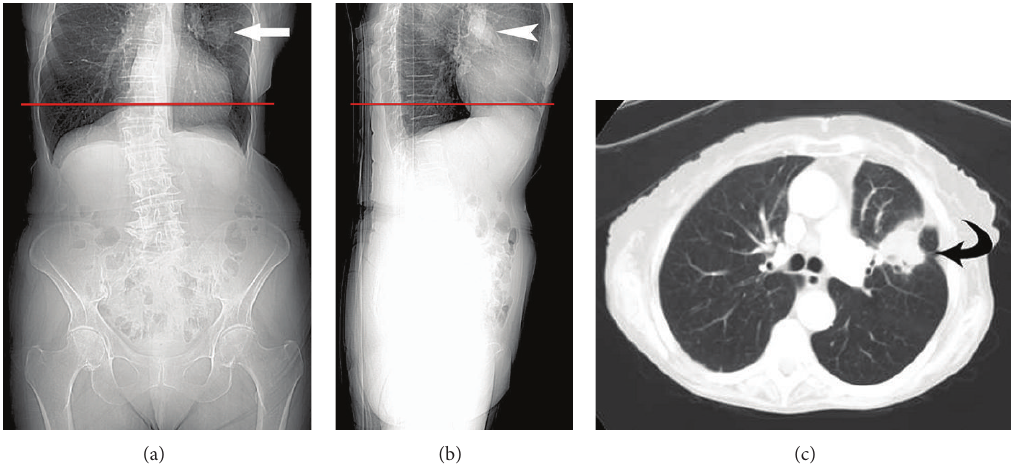
Figure 4: (a) AP and (b) lateral CT scout views demonstrate a left midupper lobe soft-tissue density mass (arrow, arrowhead). The level of the first axial image from the abdominopelvic CT is shown by the red lines, demonstrating that the scan commenced below the level of the lesion. (c) Chest CT axial image demonstrates a mass in the anterior segment of the left upper lobe (curved black arrow).